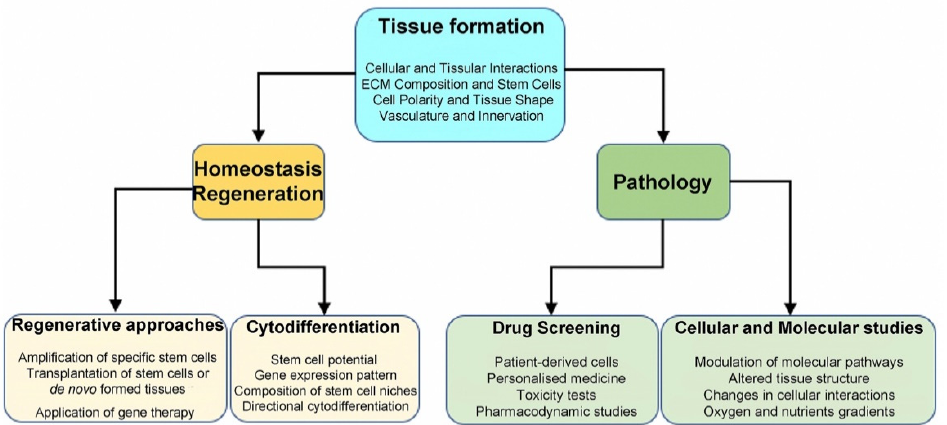
Figure 3. Summary of 3D systems and their applications. Several aspects of tissue organisation can be modelled in 3D cultures. For all applications, spheroids, organoids, and “organ-on-a-chip” represent more faithfully the main features of native tissues when compared to 2D cultures. 3D systems allow characterisation of specific stem cell populations and could be used for regenerative purposes. Furthermore, 3D structures can reproduce a disease environment and serve for drug testing.